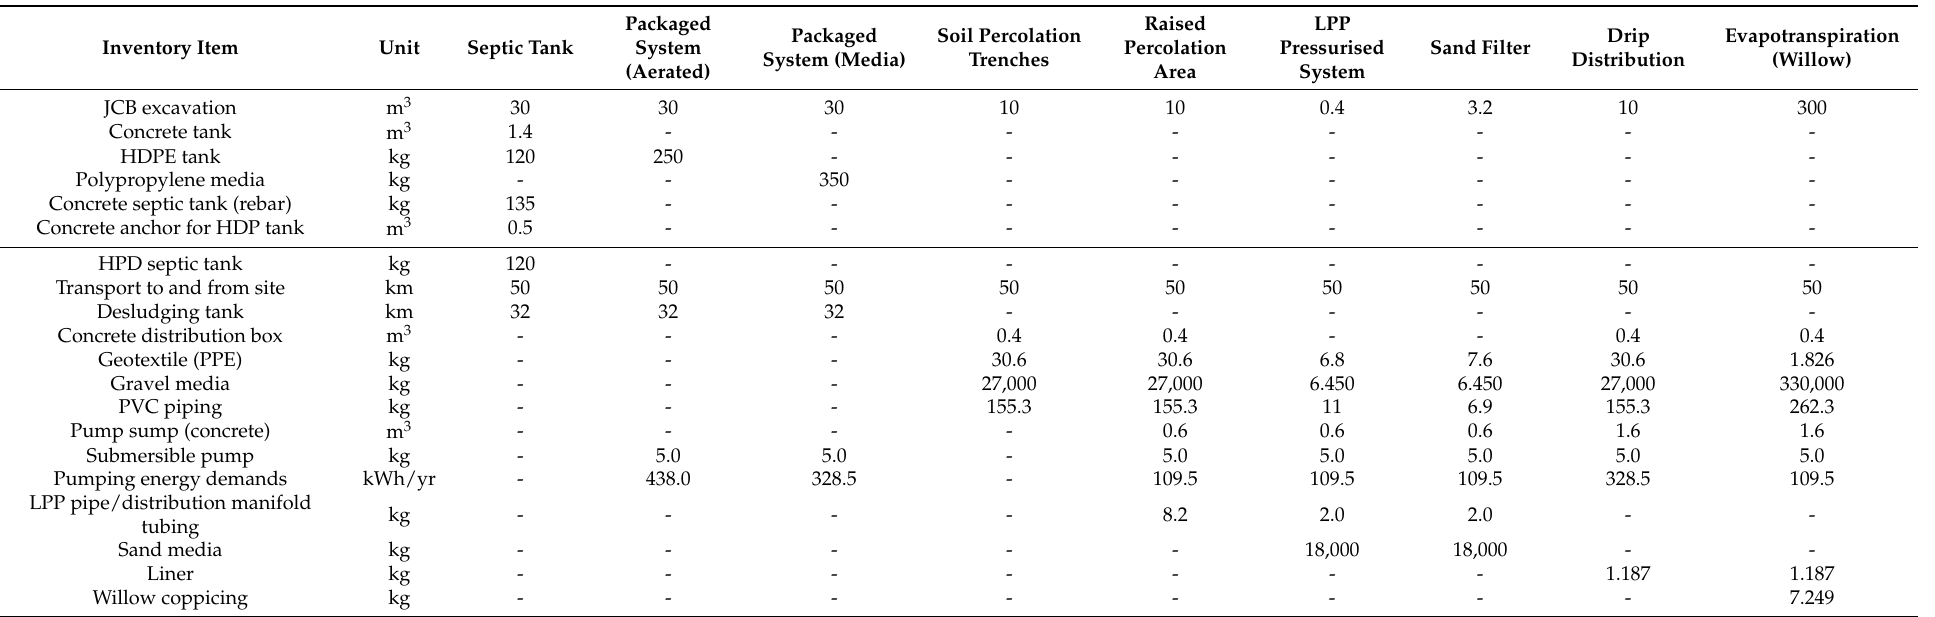
Table A2. Primary inventory data for different on-site DWWTS